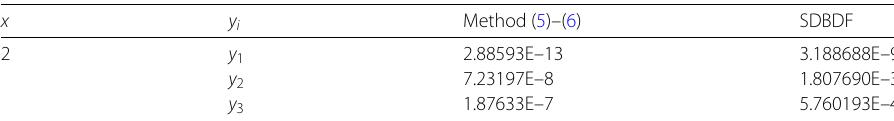
Table 2 The absolute errors for Test 2